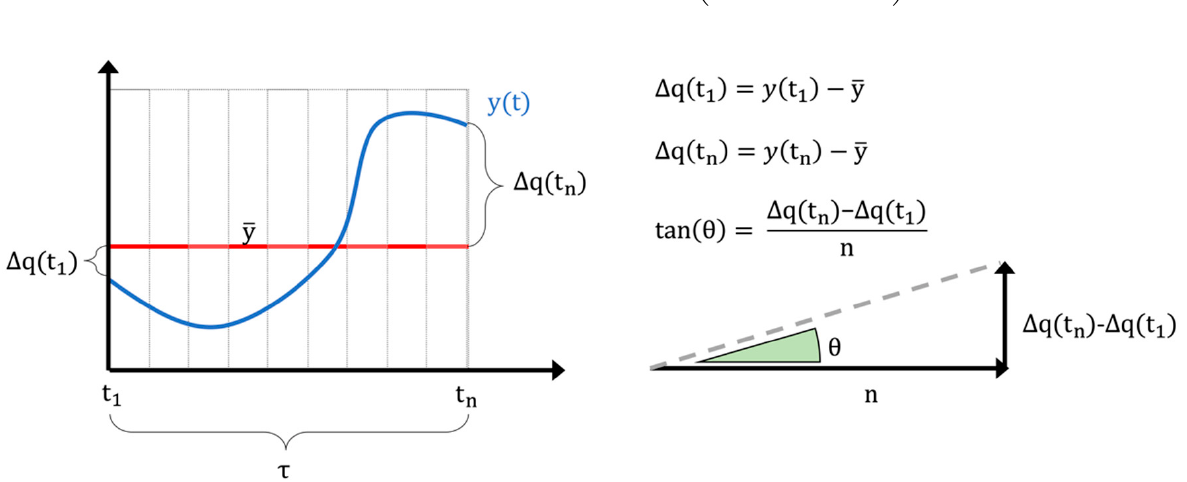
Figure 1. Definition of trend feature triangle and trend angle for a generic time series (y(t)).